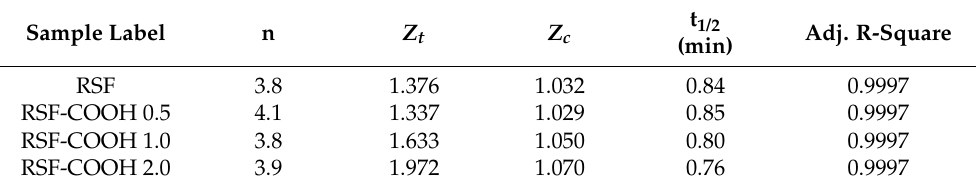
Table 3. Crystallization kinetic parameters of non-isothermal crystallization data for RSF